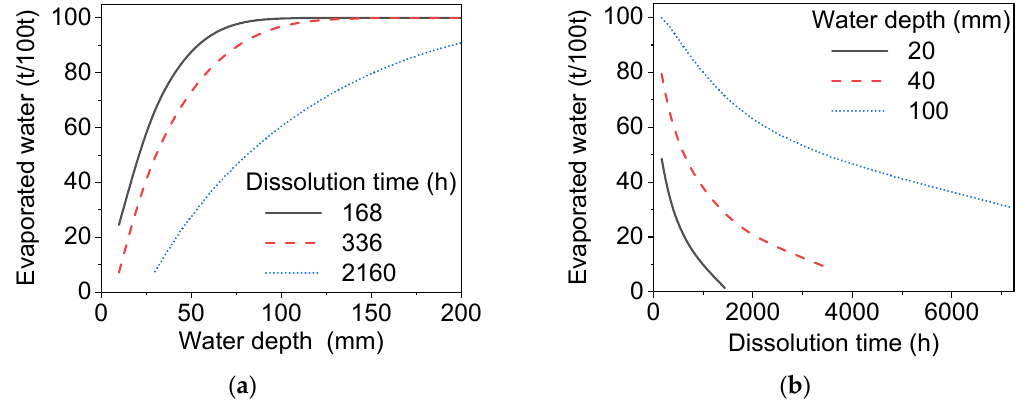
Figure 11. Technological performance under different dissolution conditions of bloedite: ( a ) amounts of dissolved solute per square meter of dissolution area; ( b ) evaporated water per unit of resulting solution.